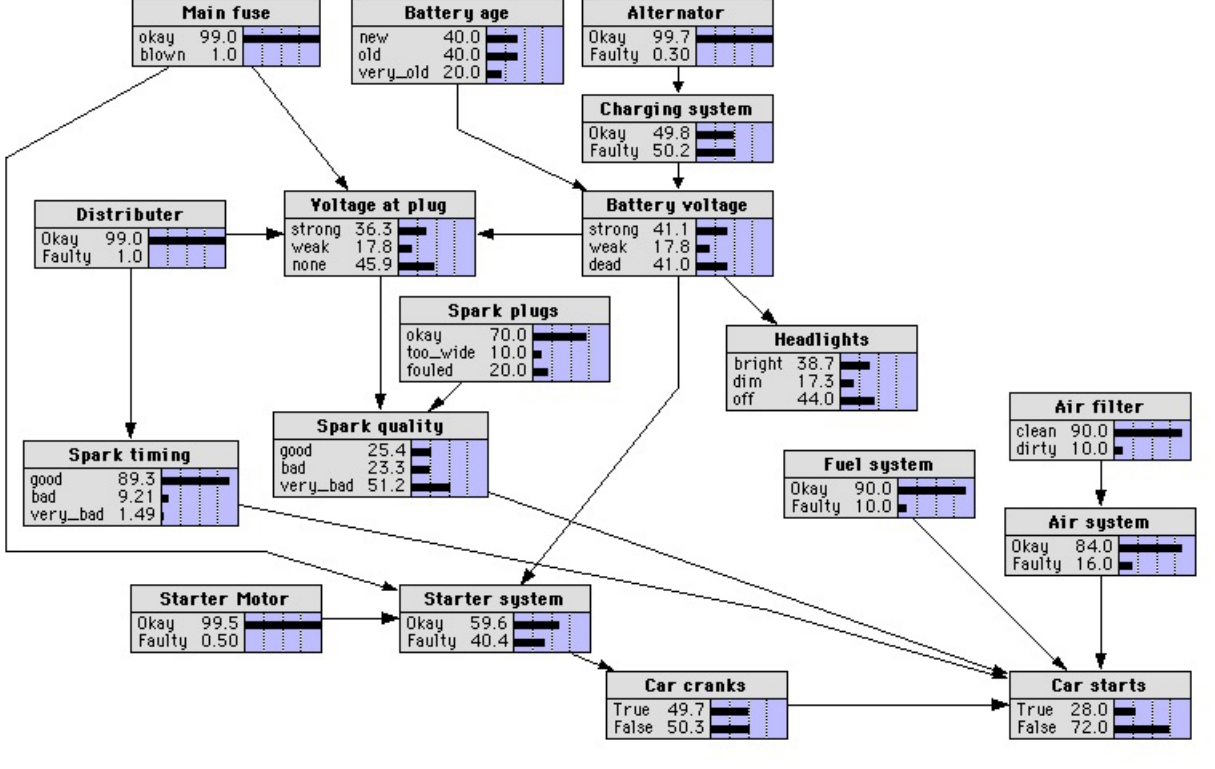
Figure 3. BN for system S